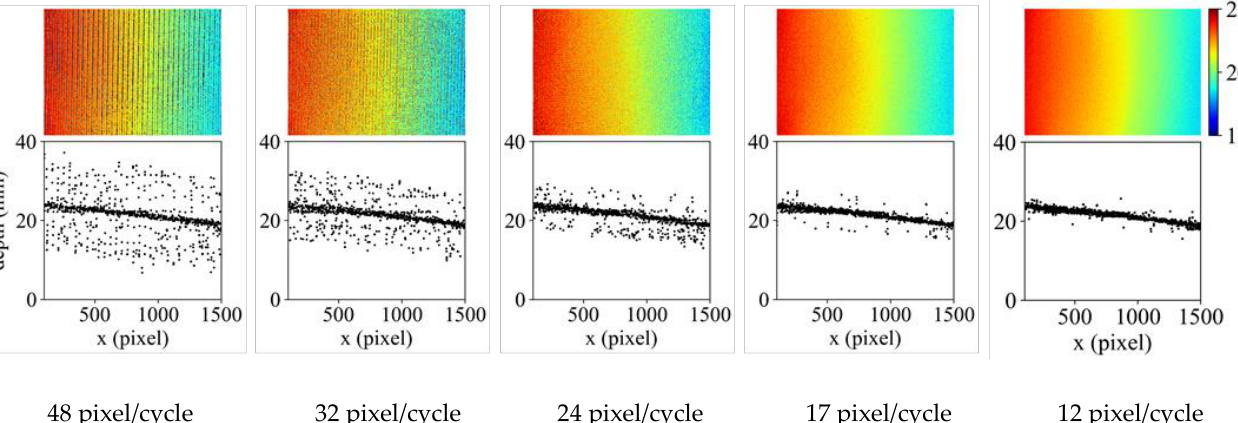
Figure 5. Results of the 3-D depth measurements by the various pixel-cycle lengths of the textures. The upper part shows the depth map of the reconstructed shape, and the lower part shows the x - z plane ( y = 600) of the reconstructed shape. Table 1. Standard errors of regression at each cycle length.